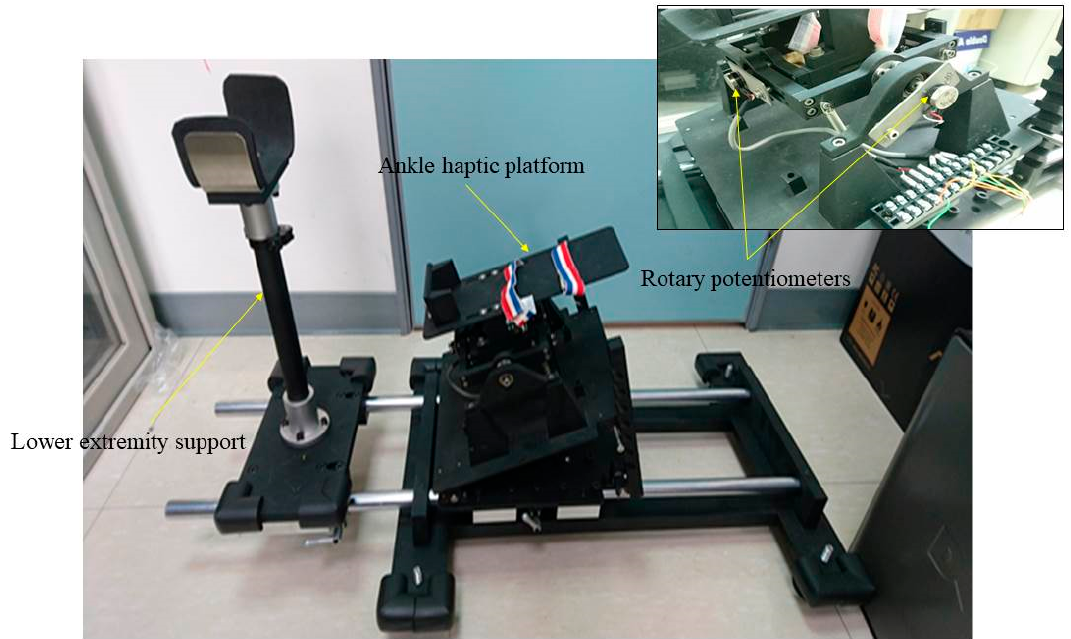
Figure 2. The multiaxis ankle-joint-perception measurement system and its components. There are several small springs under the platform, which provide force feedback of multiple movements in tested muscles during muscle perception tests. A highly adjusta- ble lower extremity support with Velcro ® was aligned with the ankle haptic platform. Each participant was asked to put their thigh on the lower extremity support and fix it with Velcro ® to avoid potential abnormal compensatory movements in the tested ankle joint (Figure 3). Figure 3. Experimental setting.